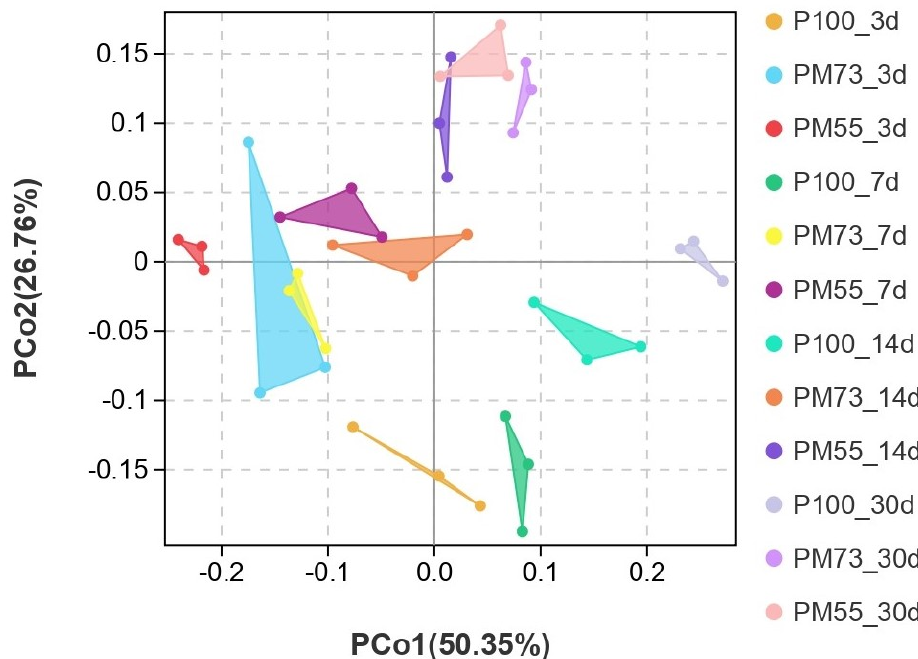
Figure 3. Principal component analysis of the bacterial community for hybrid Pennisetum and mulberry leaves mixed silage (P100, 100% hybrid Pennisetum silage; PM73, hybrid Pennisetum and mulberry leaves mix-silage in a ratio of 7:3; PM55, hybrid Pennisetum and mulberry leaves mix-silage in a ratio of 1:1; 3d, 3 days of ensiling; 7d, 7 days of ensiling; 14d, 14 days of ensiling; 30d, 30 days of